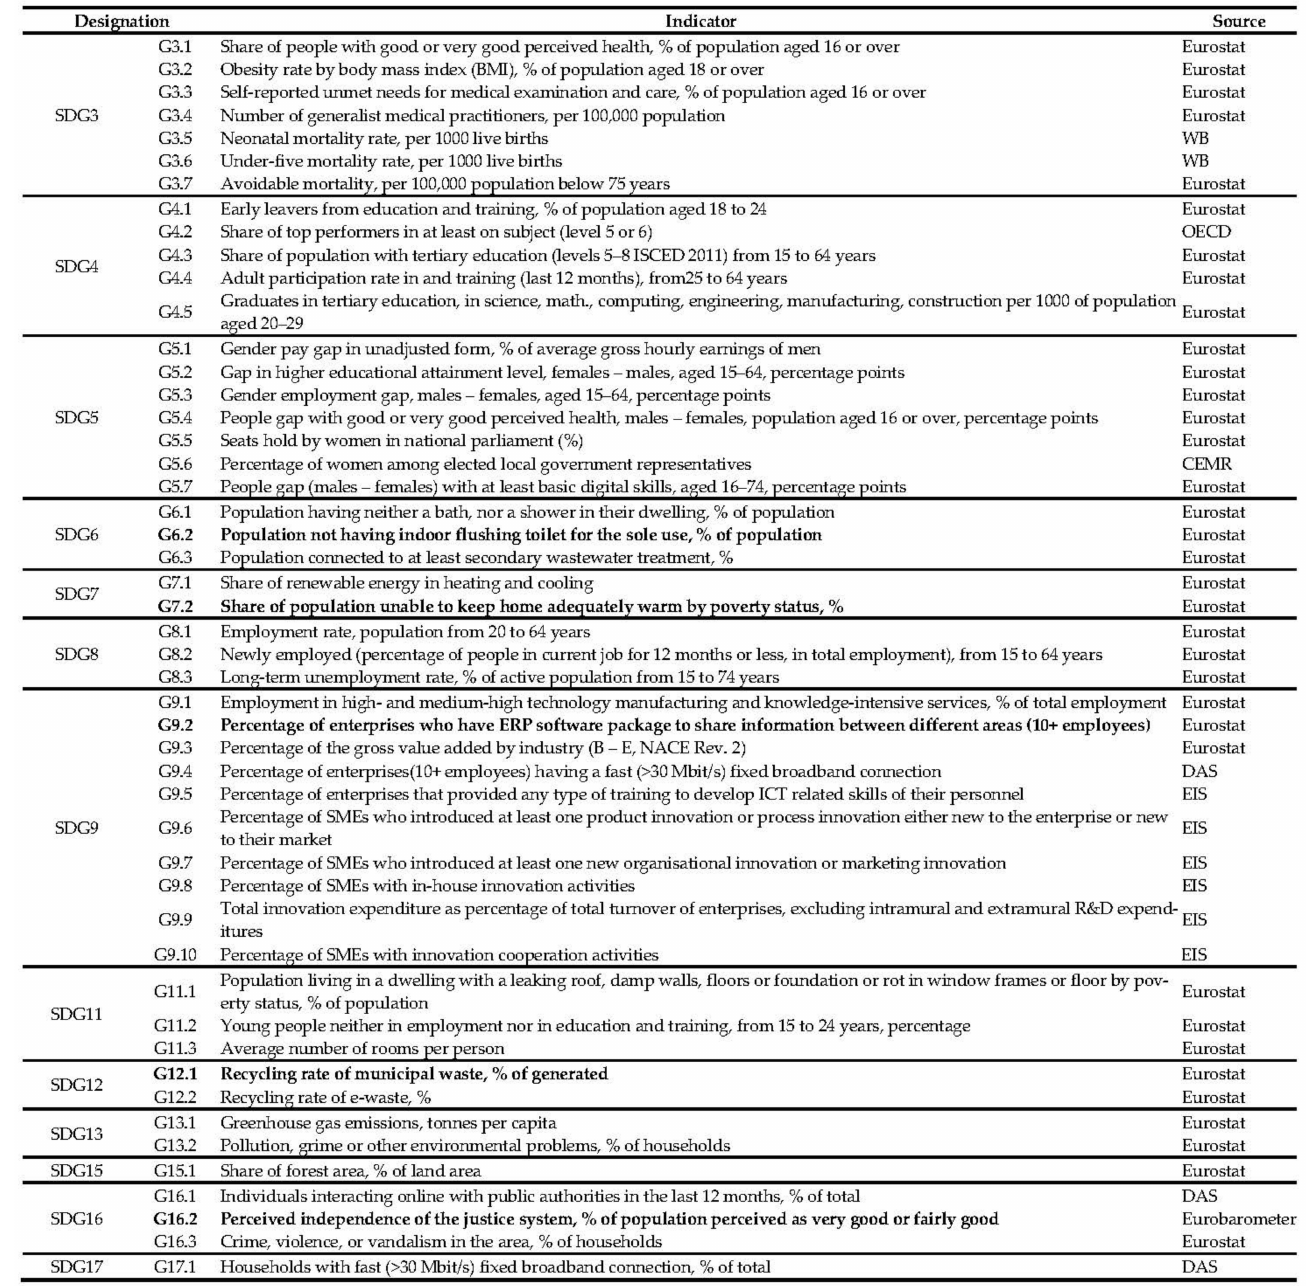
Figure A1. Selected indicators for the modelling of urban SD. Sources: CEMR—The Council of European Municipalities and Regions; DAS—The Digital Agenda Scoreboard; EIS—The European Innovation Scoreboard; OECD—The Organisation for Economic Cooperation and Development; WB—The World